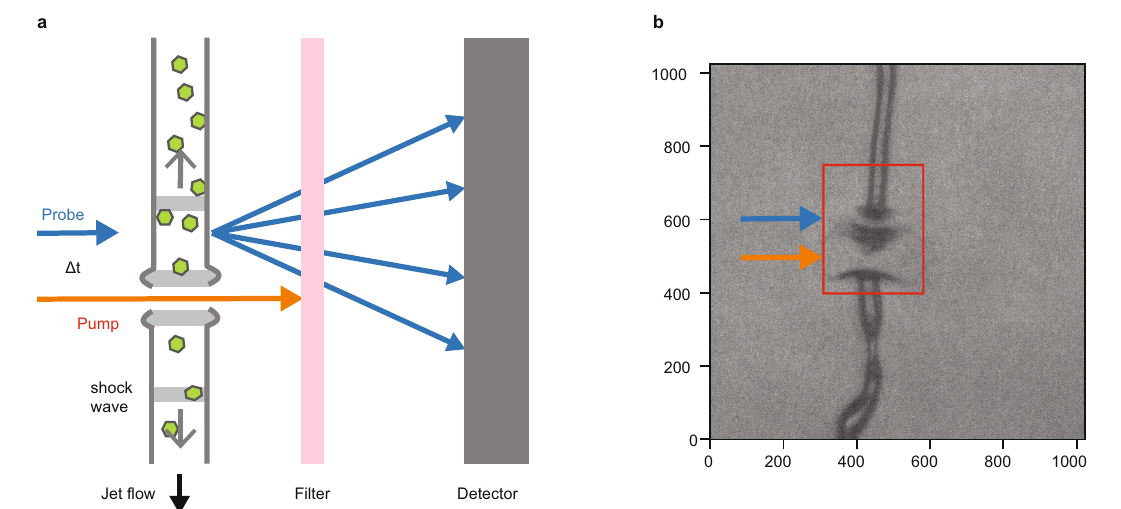
Fig. 1 Experimental setup. a Haemoglobin microcrystals were injected into the XFEL beam using a gas dynamic virtual nozzle injector 11 . The fi rst ~30 fs X-ray pulse (photon energy above the iron K-edge (7.112 keV) and a pulse energy of up to ~0.1 mJ, average value 0.03 mJ) was used as a pump, isochorically heating the jet and launching a shockwave (depicted in grey) that propagates upstream and downstream of the interaction region. The shock wave propagates at supersonic speeds and outruns the explosive gap formed in the jet. The scattered X-rays were absorbed by a thin iron fi lter and did not reach the detector. After 122.5 ns a sample segment upstream of the pump pulse was hit by a second ~30 fs X-ray pulse (photon energy just below the iron K-edge and a pulse energy of ~0.9 mJ), which was displaced by ~5 µ m towards the nozzle. In this case, the scattered X-rays passed through the iron fi lter, reaching the detector. The setup differs from previous two-colour X-ray pump/X-ray probe experiments 33,34 due to the displacement of the pump pulse. b Femtosecond snapshot image of the jet a few nanoseconds after the probe pulse had interacted with the jet. Explosions induced by the pump (orange arrow) and probe (blue arrow) pulse are clearly visible. Although present in the jet, the shockwaves are not visible in the camera images. In jets this small, the optical path difference induced by shock compression does not suf fi ce to observe the shock. A movie showing consecutive pump – probe pairs hitting the jet is available as Supplementary Movie 1. The jet instabilities (wiggling) are ascribed to the presence of crystals in the jet. These instabilities are largely absent in homogeneous (crystal-free) jets and become more pronounced with increasing crystal